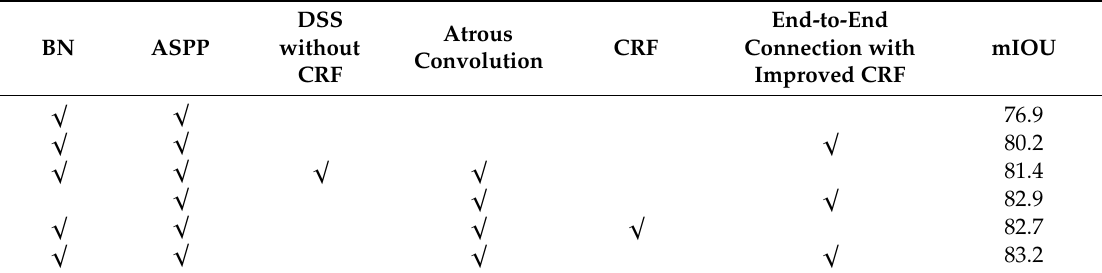
Table 6. Employing the model on the dataset.